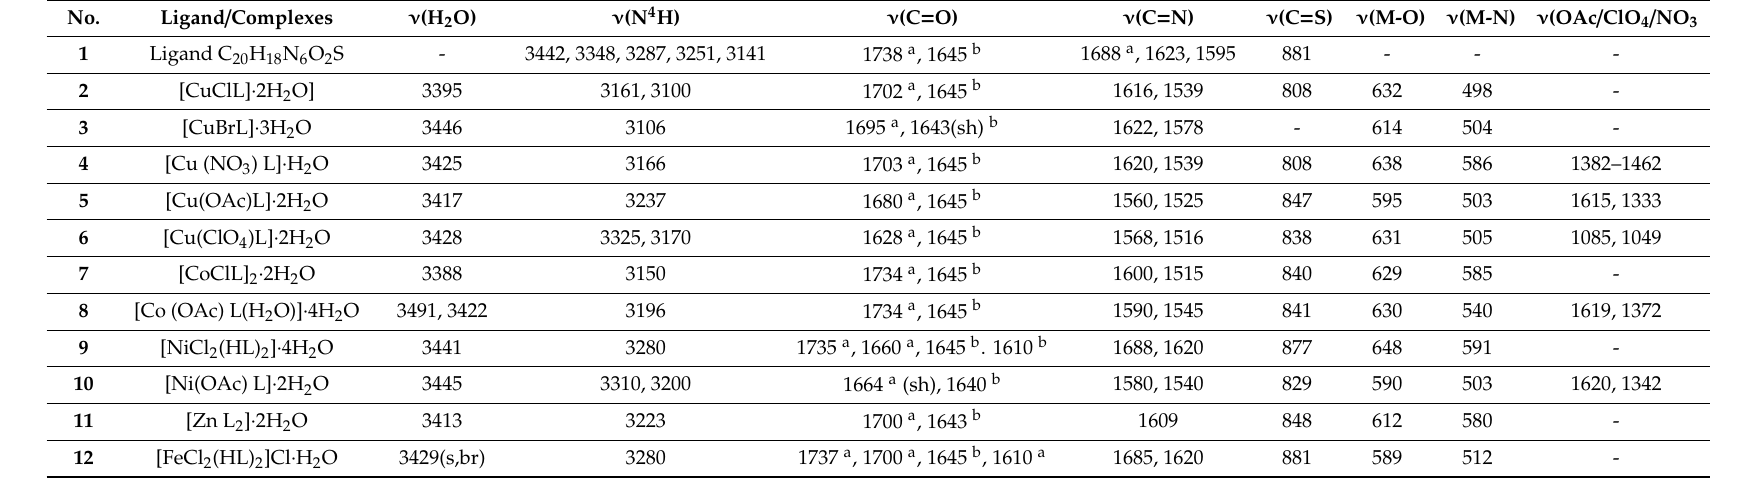
Table 2. IR spectral bands (cm − 1 ) for ligand 1 and its metal complexes 2 – 12 and their